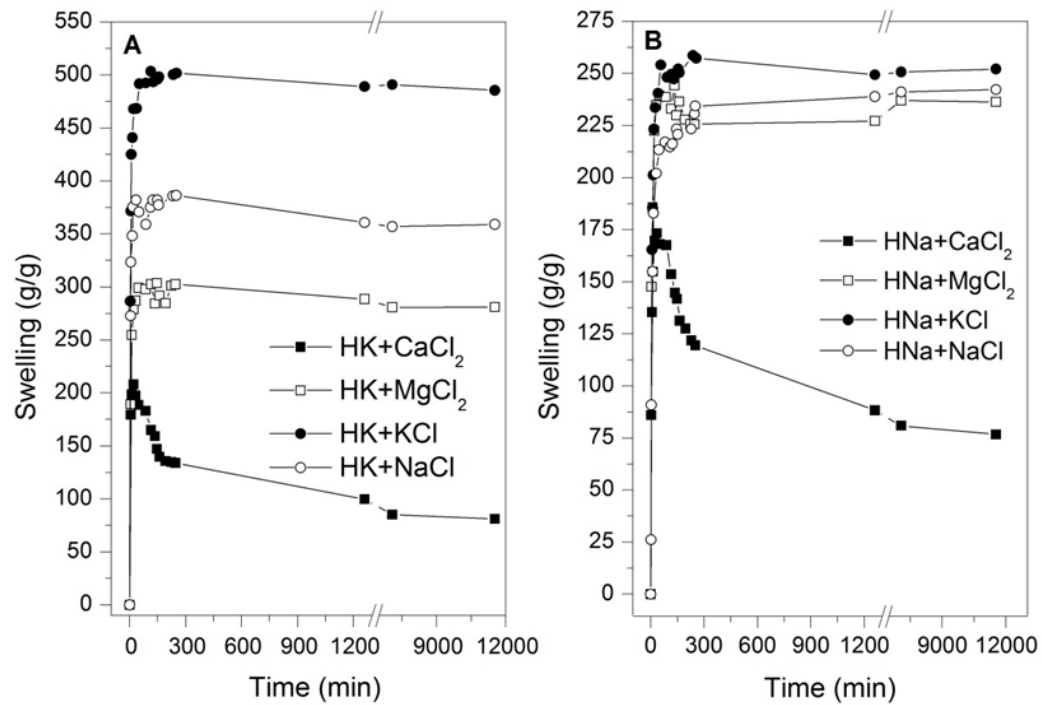
Figure 2. Swelling kinetics of hydrogels in saline solutions. ( A ) HK and ( B ) HNa.